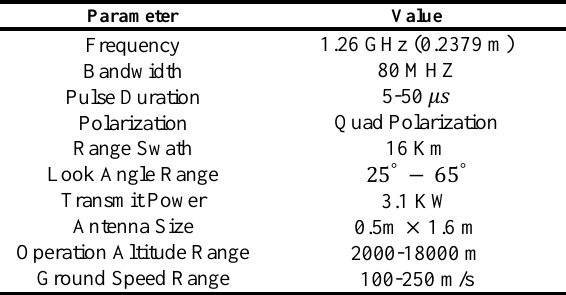
Table 2 . The characteristics of the UAVSAR satellite.